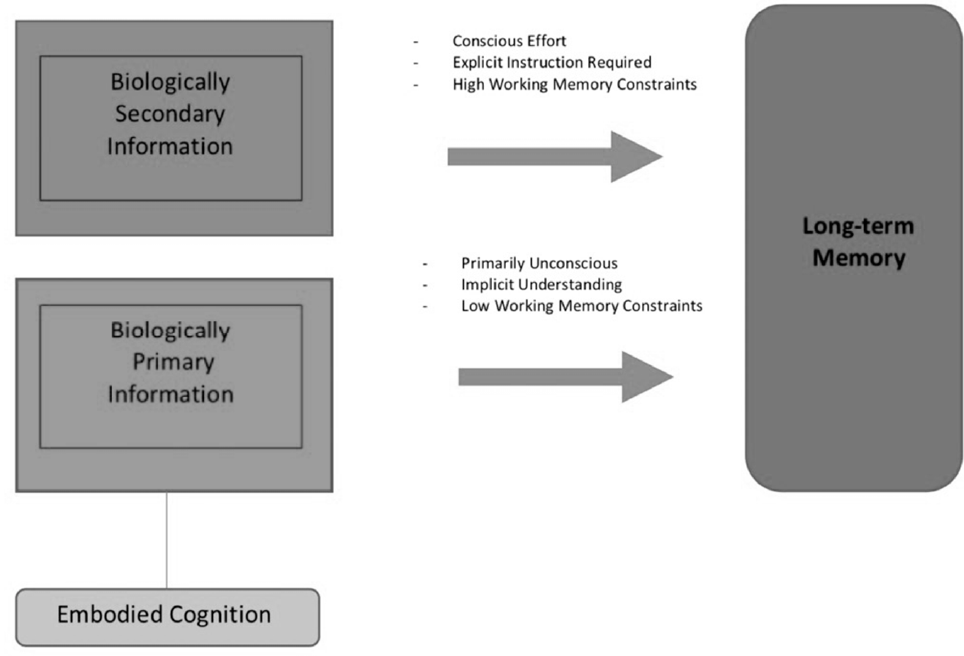
Figure 1. Theoretical framework for Cognitive Load Theory (CLT) and Embodied Cognition (EC).